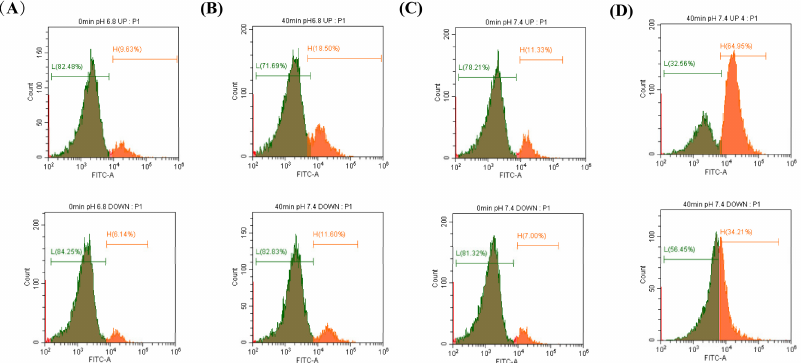
Figure 2. The changes in [Ca 2+ ]i concentration during sperm incubation were detected by flow cytometry. ( A – D ) Proportion of sperm with high calcium ion concentrations in the upper and lower diluents when sperm were incubated at pH 6.8 and 7.4 for 0 min and 40 min. The OCPC colorimetric method was also used to detect the [Ca 2+ ]i concentration